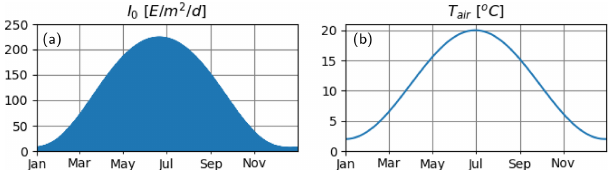
Figure 2. Atmospheric variables. (a) Astronomically estimated in- stantaneous irradiance at the water surface and (b) prescribed air